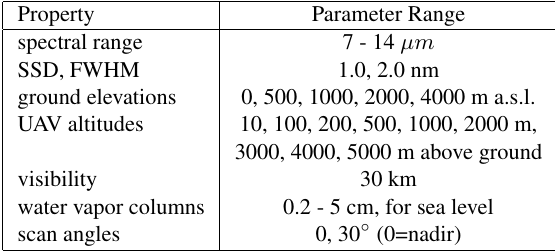
Table 1. Specifications of the generic LUT used for emissivity retrieval.